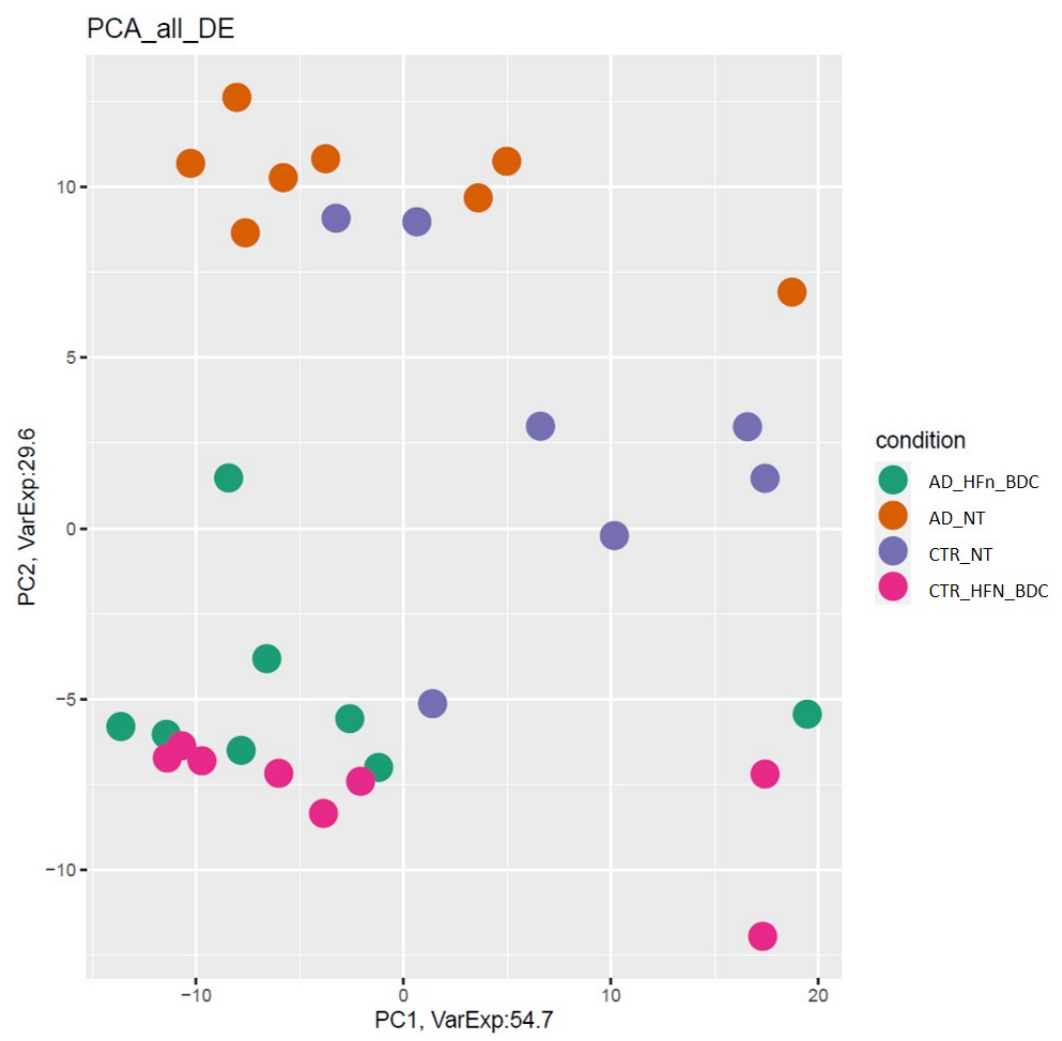
Figure 3. PCA of differentially expressed genes. All comparisons are given between the AD, AD BDC-HFn, and CTR BDC-HFn compared to CTR (AD_NT N° = 8, CTR_NT N° = 7, AD_Hfn_BDC HFn, and CTR BDC-HFn compared to CTR (AD_NT N ◦ = 8, CTR_NT N ◦ = 7, AD_Hfn_BDC N ◦ = 8, N° = 8, and CTR_Hfn_BDC N° = 8). and CTR_Hfn_BDC N ◦ =